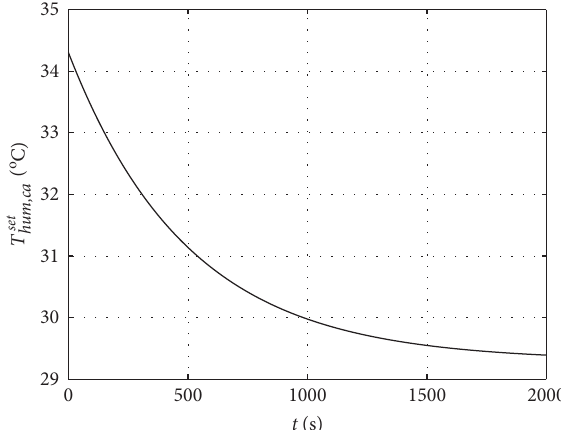
Figure 4: The profile of the humidifier temperature at the cathode side.